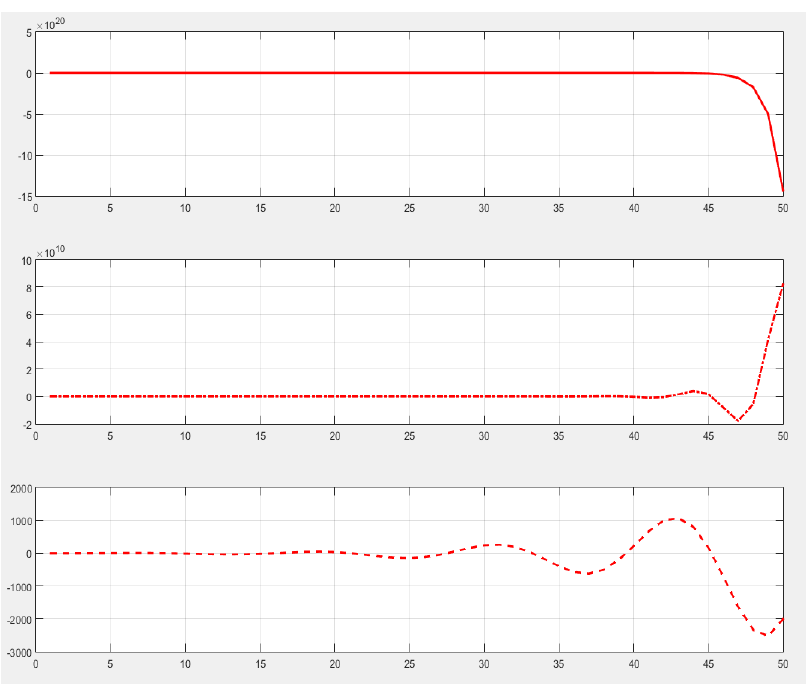
Fig. 7 Time domain presentation of signals from CF based on phrase No.